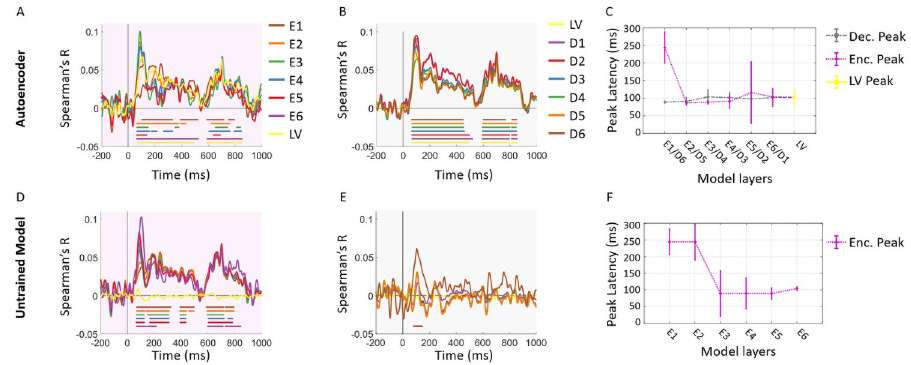
Fig 7. The impact of architecture and training procedure on the representational similarity of the model and brain temporal data. (A) Comparison of the encoder layers of the autoencoder model with MEG representations. We correlated the encoder layer RDMs with subject-specific time-resolved MEG RDMs resulting in fifteen correlation time courses. We then averaged these time courses over participants. (B) Comparison of the decoder layers of the autoencoder model with MEG representations. Correlation of the decoder layer RDMs and time-resolved MEG RDMs. The color-coded lines below the curves show the time points when the correlations are significantly above zero (N = 15; permutation tests; cluster definition threshold P < 0.01; cluster threshold P < 0.05). (C) Peak latency for encoder and decoder of the autoencoder model. Error bars are expressed in standard error of the mean. (D) Comparison of the encoder layers of the untrained model with MEG representations. We correlated the encoder layer RDMs with subject-specific time-resolved MEG RDMs resulting in fifteen correlation time courses. We then averaged these time courses over participants. (E) Comparison of the decoder layers of the untrained model with MEG representations. Correlation of the decoder layer RDMs and time-resolved MEG RDMs. The color-coded lines below the curves show the time points when the correlations are significantly above zero (N = 15; permutation tests; cluster definition threshold P < 0.01; cluster threshold P < 0.05). (F) Peak latency for encoder and decoder of the untrained model. Error bars are expressed in standard error of the